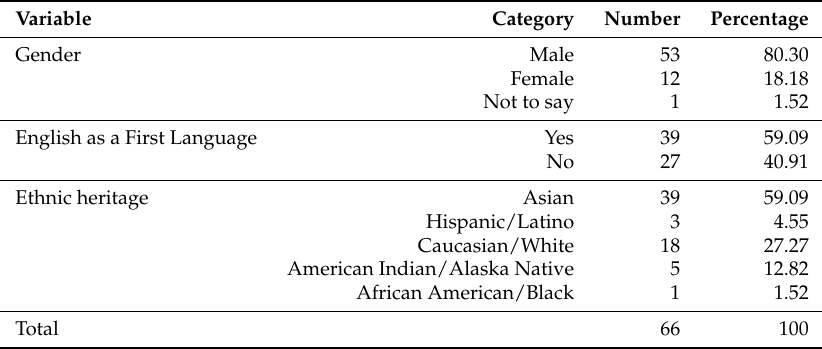
Table 2. General information about the